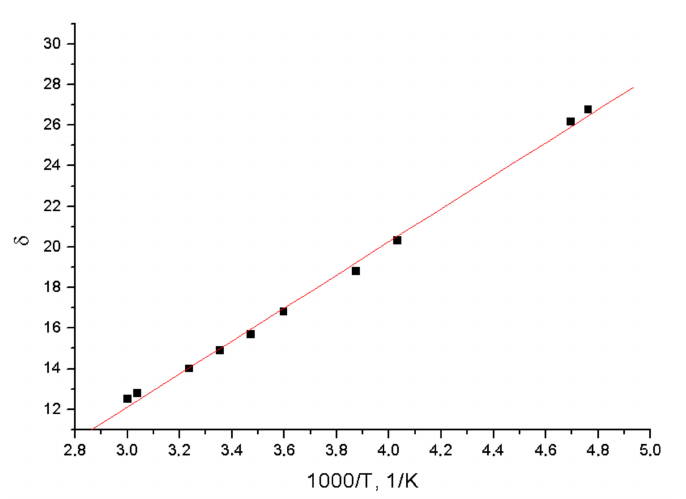
Figure 6. Temperature dependence of the chemical shifts of averaged (by chemical exchange) signal «1» of the Co(II) calix[4]arene complex. The solvent is CDCl 3 /CD 2 Cl 2